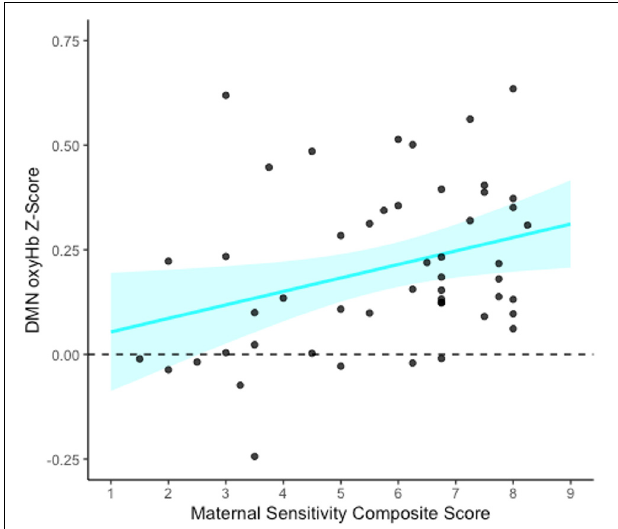
FIGURE 4 | Association between maternal sensitivity composite and infant default mode network (DMN) connectivity at 5 months. This figure shows the unadjusted relation between the maternal sensitivity composite (average of maternal sensitivity vs. insensitivity and cooperation vs. interference scales) and DMN functional connectivity (oxyHb) Z-scores. The blue shaded area represents the upper and lower bounds of the mean 95% confidence interval for the raw data. N =